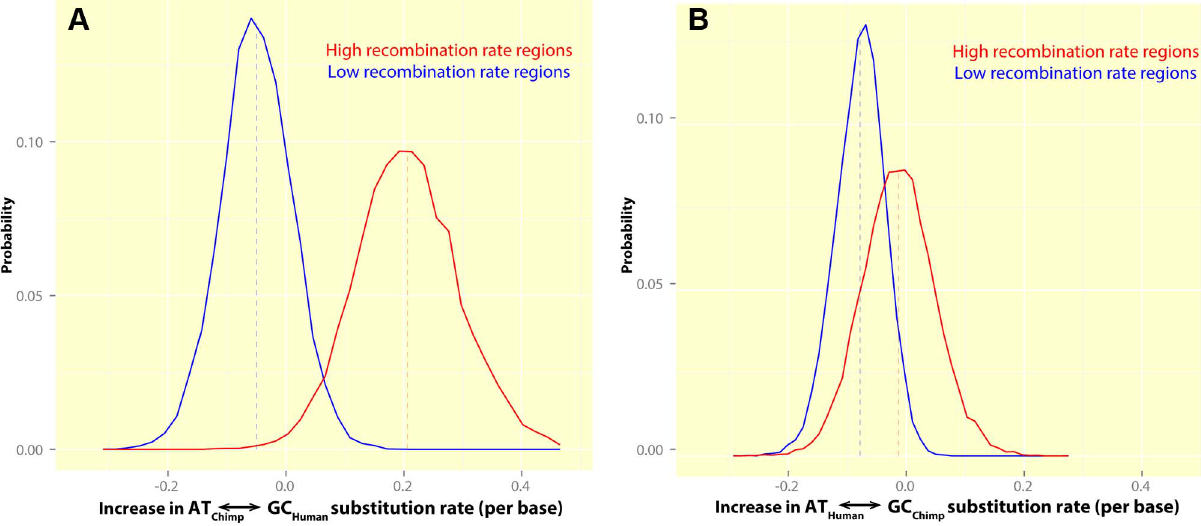
Figure 7. The rate of GC-biased substitutions in human and chimpanzee, in human hotspots, suggests no sharing of human and chimpanzee hotspots in PAR1. These plots show histograms for the estimated increase in the rate of GC-biased transition substitutions in regions overlapping human hotspots (red) and coldspots (blue), relative to the rest of PAR1 in: (A) Human: High recombination rate regions show a significant excess of GC-biased transitions in humans ( + 0.21% per base) while low recombination rate regions show a lower substitution bias towards GC transitions ( 2 0.05% per base) relative to regions with intermediate rates. The difference between hotspots and coldspots is significant ( P ~ 6 | 10 { 3 ). (B) Chimpanzee: There is no systematic increase in the rate of GC-biased transitions in chimpanzee ( 2 0.01% per base) in regions containing human hotspots. The difference between hotspots and coldspots is not significant ( P ~ 0 : 20 ). doi:10.1371/journal.pgen.1004503.g007 PLOS Genetics |